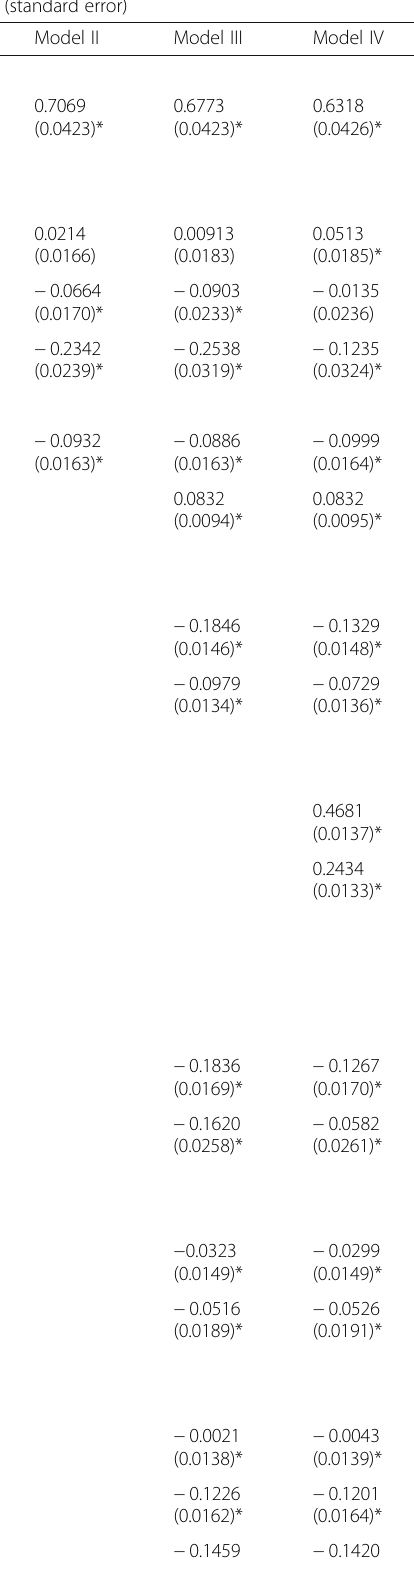
Table 5 Results from dynamic random effects models for infant mortality, Nigeria, 1980 –